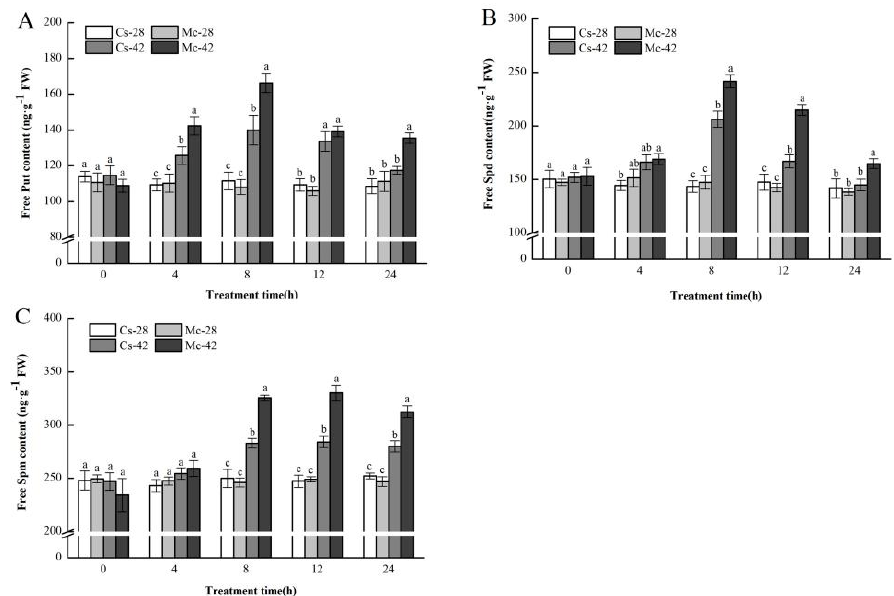
Figure 3. Interactive e ff ects of bitter melon rootstock and grafted cucumber seedlings on the time course change of polyamine contents ( A ): Putrescine (Put), ( B ): Spermidine (Spd), ( C ): Spermine (Spm) in grafted cucumber leaves under heat stress conditions. The bars represent the mean ± SE values of at least three independent experiments. Self-grafted plants exposed to 28 ◦ C / 18 ◦ C (day / night), Cs-28; bitter-melon-grafted plants exposed to 28 ◦ C / 18 ◦ C (day / night), Mc-28; self-grafted plants exposed to 42 ◦ C / 32 ◦ C (day / night), Cs-42; bitter-melon-grafted plants exposed to 42 ◦ C / 32 ◦ C (day / night), Mc-42. Di ff erent letters indicate significant di ff erences at p < 0.05 according to Duncan’s multiple range